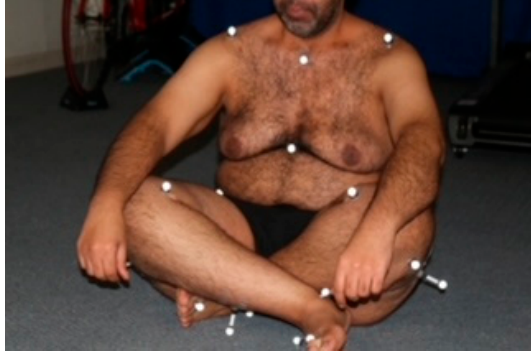
Figure 2. The cross-legged si tt ing